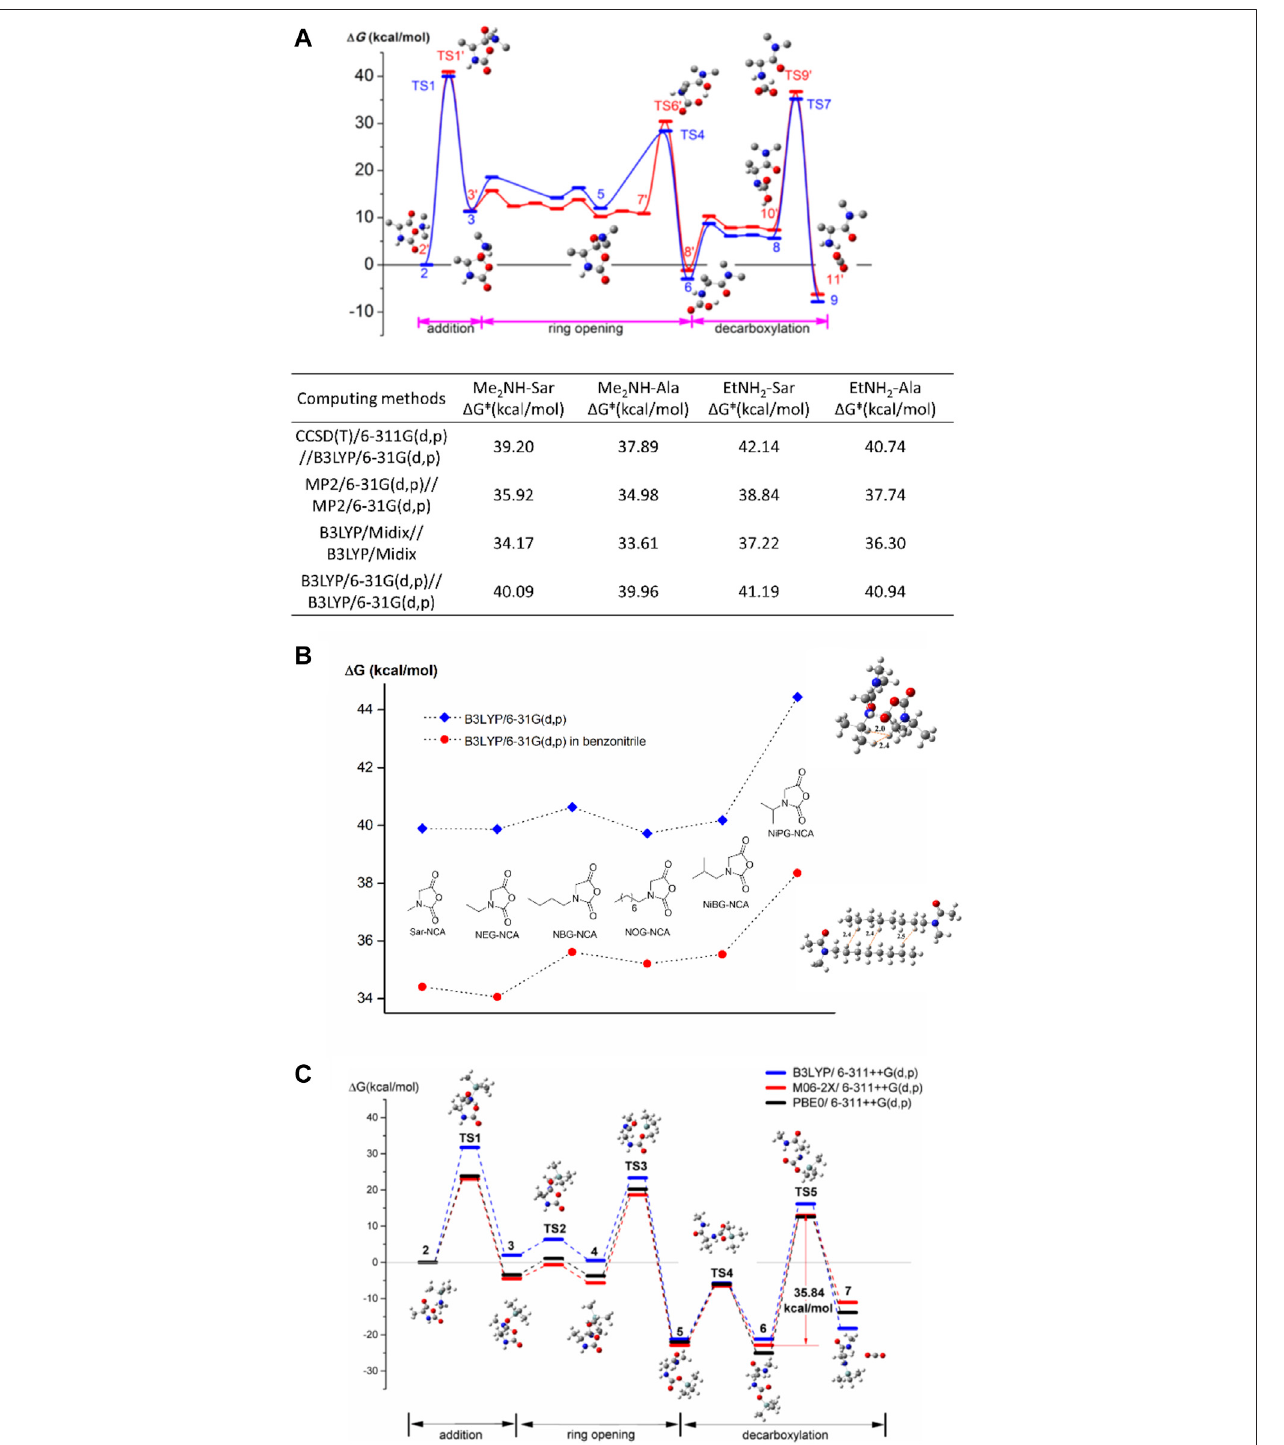
FIGURE 2 | (A) The whole pro fi les of Gibbs free energy barriers in the ring opening polymerization of Ala-NCA initiated by dimethylamine and ethylamine with 3- dimensional models. Some hydrogen atoms are omitted for clarity. Thermodynamics and kinetic data, calculated by four basis set methods of energy barrier are listed. (B) TheGibbsfreeenergybarriersincarbonyladditionstepofsixNNCAsinavacuumandsolutionofbenzonitrile.TransitionstatesonthecarbonyladditionstepofNiPG- NCAandoptimizedgeometryofanaggregateddimerwithoctylsidegroupsareillustratedwiththedistancebetweensomehydrogenpairsintheunitofÅ.Dashline is used as a guide. (C) The whole pro fi les of Gibbs free energies in ring opening polymerization of Ala-NCA initiated by MeNHTMS in benchmark. Reproduced with permission from corresponding references.